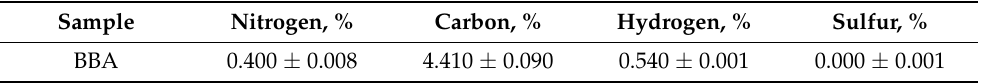
Table 2. Elemental analysis of biomass bottom ash (BBA).